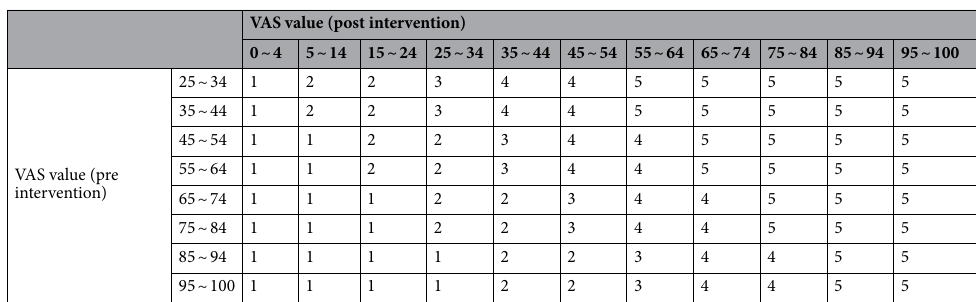
Table 2. Improvement criteria table about VAS value. 1. Very much improved, 2. Much improved, 3. Minimally improved, 4. Static, 5.